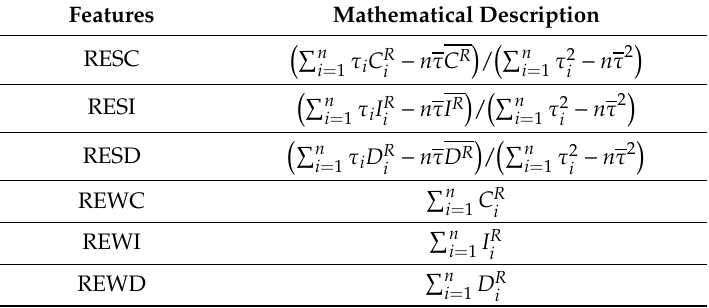
Table 1. The mathematical description of six selected features (i.e., RESC, RESI, RESD, REWC, REWI, REWD). RESC is the right edge slope of CDW. RESI is the right edge slope of IDW. RESD is the right edge slope of DDW. REWC is the right edge waveform summation of CDW. REWI is the right edge waveform summation of IDW. REWD is the right edge waveform summation of DDW.